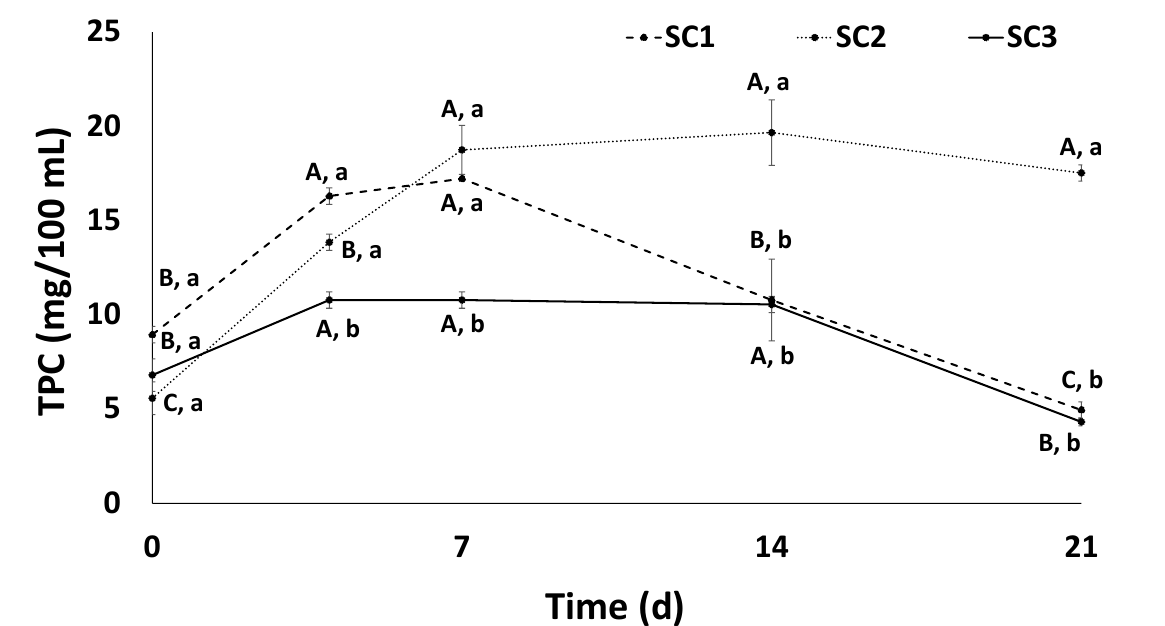
Figure 5. Evolution of total phenolic content (mg/100 mL) in ST kombuchas fermented using SCOBYs 1, 2, and 3 (SC1, SC2, SC3). Different letters show statistical significance ( p ≤ 0.05) between different fermentation days for the same SCOBY (A–C) and between different SCOBYs for the same fermentation day